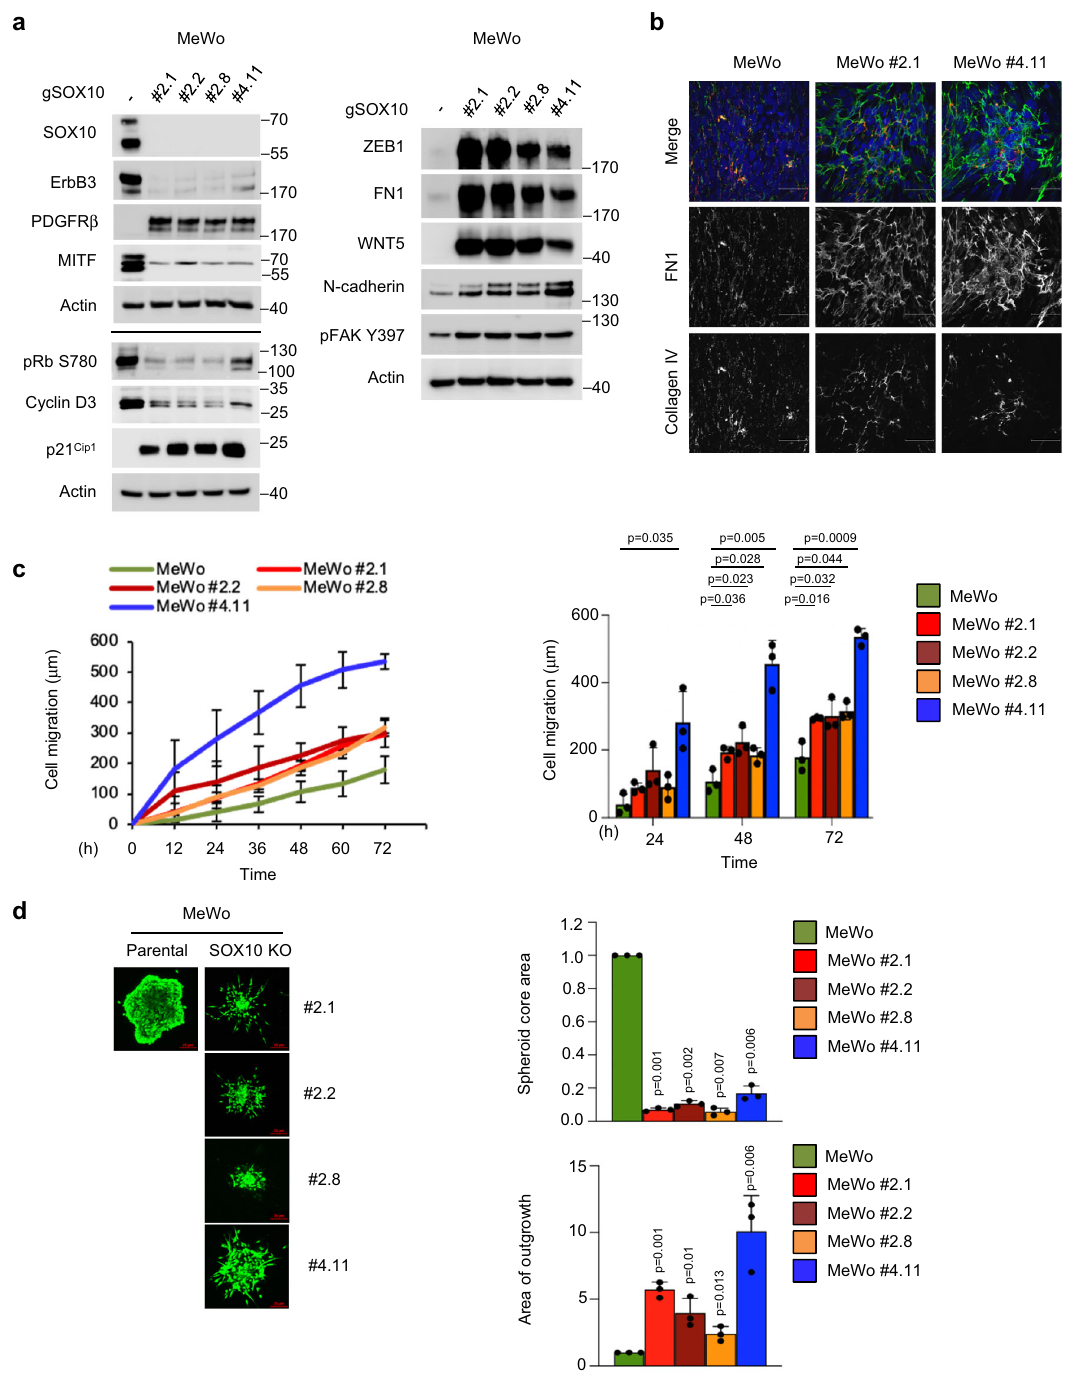
Fig. 3 SOX10 regulates the expression of genes associated with a slow-cycling and more invasive phenotype. a The same number of MeWo parental and MeWo CRISPR SOX10 knockout (clone # 2.1; 2.2; 2.8; 4.11) cells were seeded in six-well plates for each cell line. Cells were lysed and lysates western blotted as indicated. The experiment was repeated independently two times with similar results. b MeWo parental, MeWo #2.1, and MeWo #4.11 cells were plated on coverslips coated with 0.2% gelatin. The next day, cells were treated with ascorbic acid (50 µ g/ml) for 6 days. Treatment was renewed every 48 h. At the end of the experiment, cells were permeabilized, fi xed, and stained for FN1 and collagen IV. The experiment was performed independently twice, and representative images are shown. Scale bars, 50 μ m. c Scratch-wound assay comparing MeWo CRISPR SOX10 knockout (clones # 2.1; 2.2; 2.8; 4.11) cells to parental cells. Shown is the mean ± SD from three independent experiments. p -values were calculated using a two-sided t -test and p -values for signi fi cant comparisons are shown. d Spheroid in 3D collagen comparing MeWo CRISPR SOX10 knockout (clones # 2.1; 2.2; 2.8; 4.11) cell lines to parental cells. Shown is the mean ± SD from three independent experiments. Scale bar, 25 μ m. p -values were calculated using a two-sided one- sample t -test of the null hypothesis and p -values for each comparison are